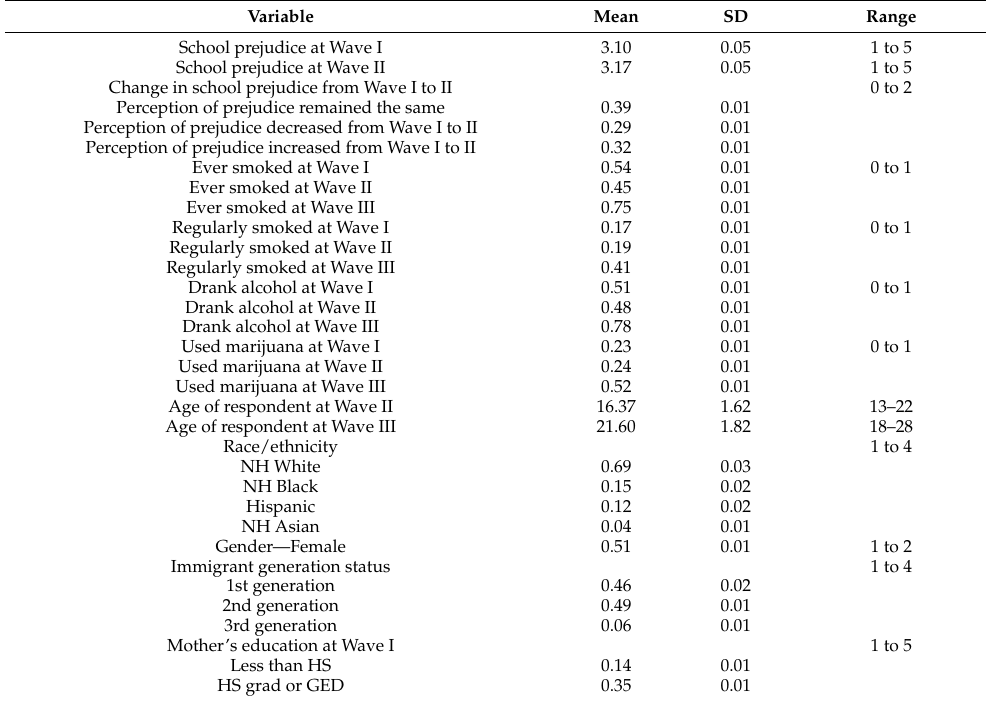
Table 1. Summary Statistics for the Analytic